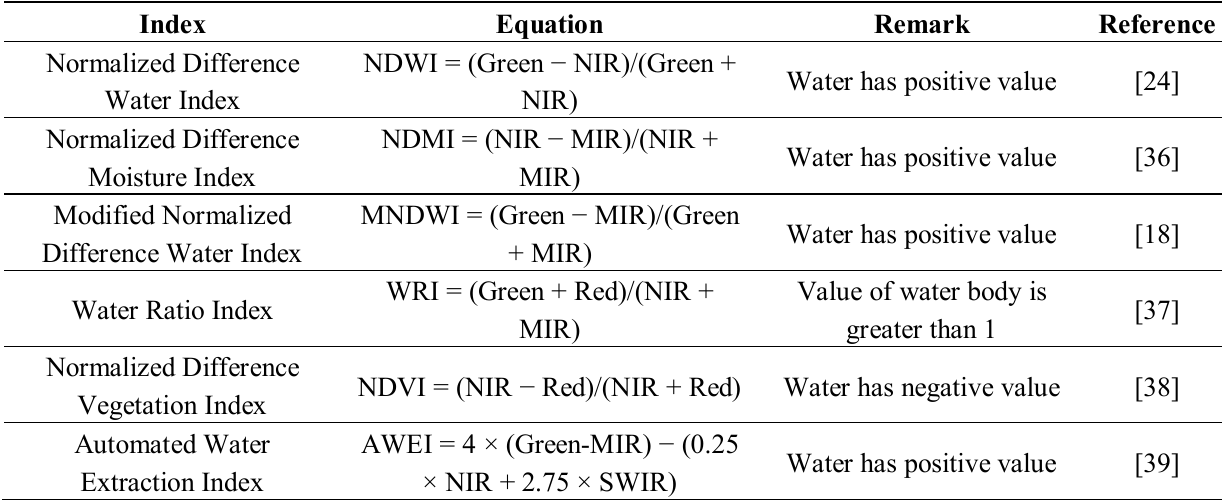
Table 2. Satellite-derived indexes used for water features extraction (in Landsat imagery: Green = Band 2, Red = Band 3, NIR (near-infrared) = Band 4, MIR (middle-infrared) = Band 5, SWIR (shortwave-infrared) = Band